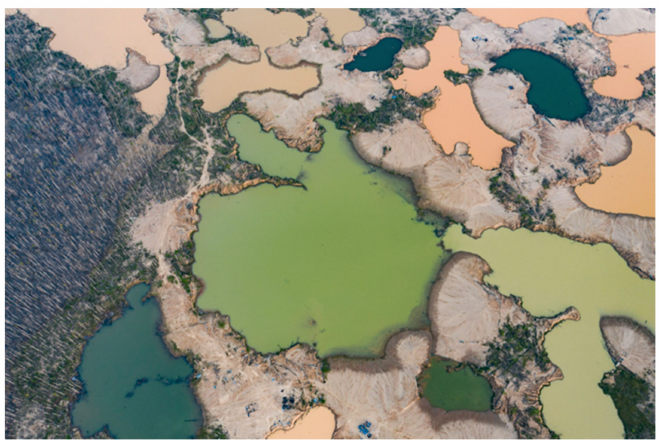
Figure 1. Mining ponds in La Pampa, Peru, showing a range of activity levels. Deep green ponds indicate the presence of algae and the cessation of mining activity. Chalky clay-colored ponds contain high levels of suspended sediment and are currently actively mixed. Light green ponds, such as the one in the center of the image, are transitioning from active status to inactive